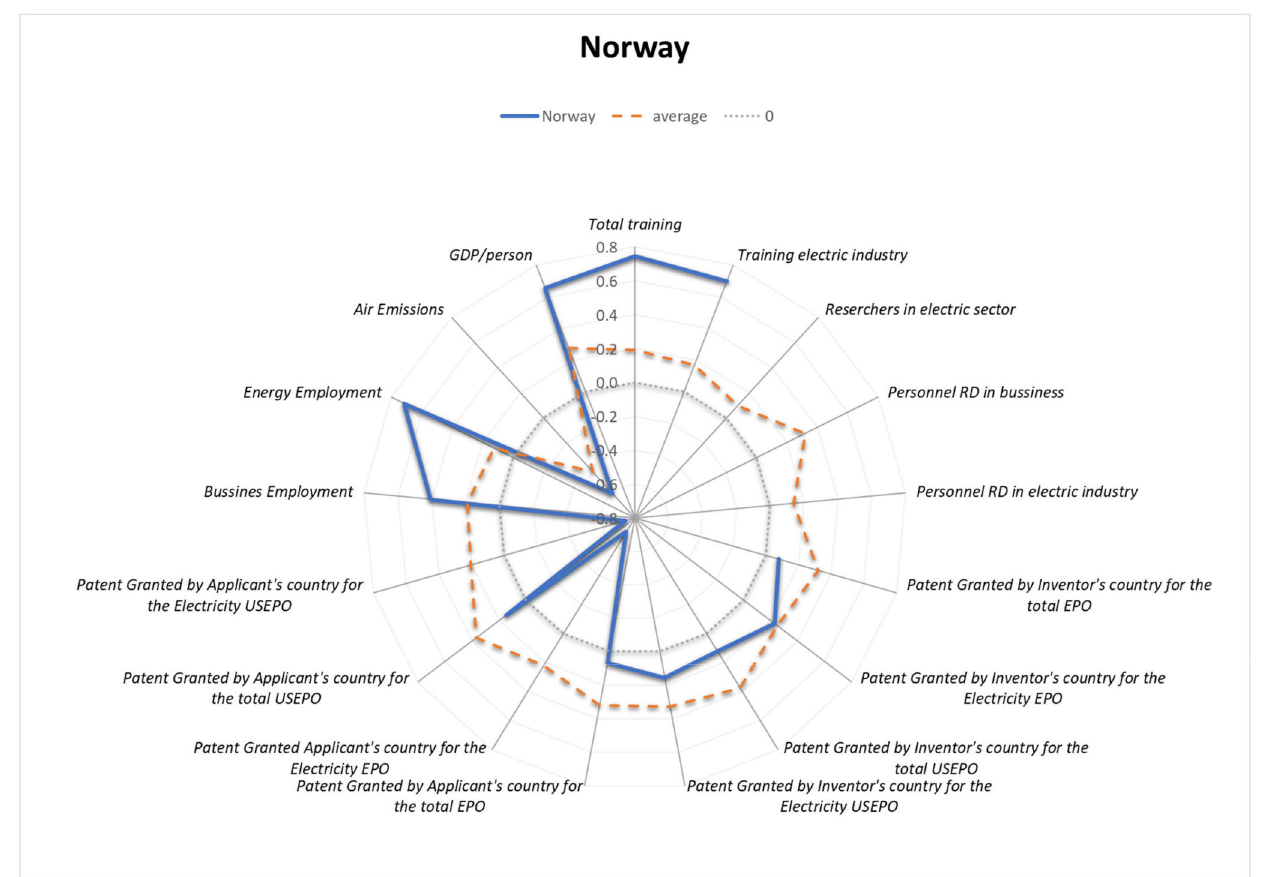
Figure 28. Synergy and trade-off occurrence—NO. Source: Authors’